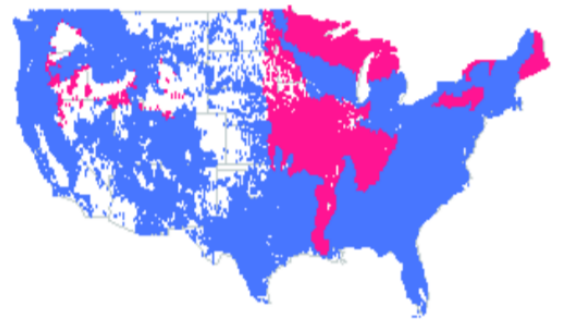
Figure 3. Blue areas are inventory plots belonging to ecoregions where basal area means behave as a random walk with normal increments; pink areas—plots in ecoregions where basal area means do not fit the random walk model (36).